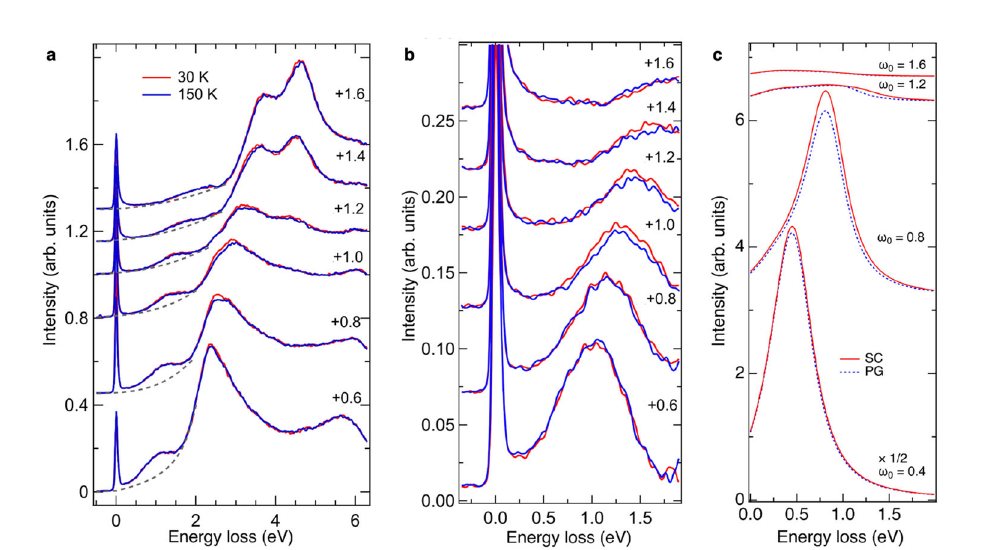
b Zoom-in spectra of a after removing the tail of RIXS induced by the transition from the incoherent LHB to the IGB. c Calculated RIXS for Q ∥ =( π /2, 0) with the same condition as in Fig. 2, except for Γ =0.07eV and η =0.1eV. For clarity, all spectra are plotted with a vertical offset, of which are identical for each incident photon energy in the same plot.